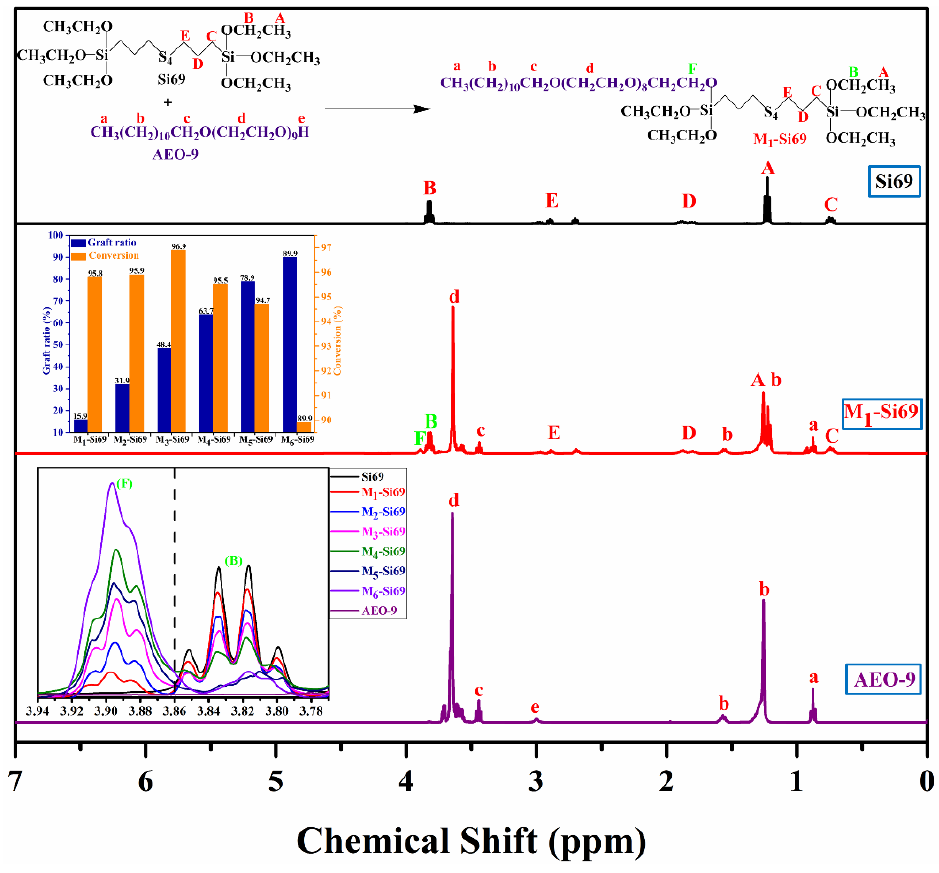
Figure 2. 1 H NMR spectra of Si69, M x –Si69, and AEO-9; graft ratio of Si69; and conversion of AEO-9 calculated with 1 H NMR [25]. Table 1. Formulation of silica/rubber